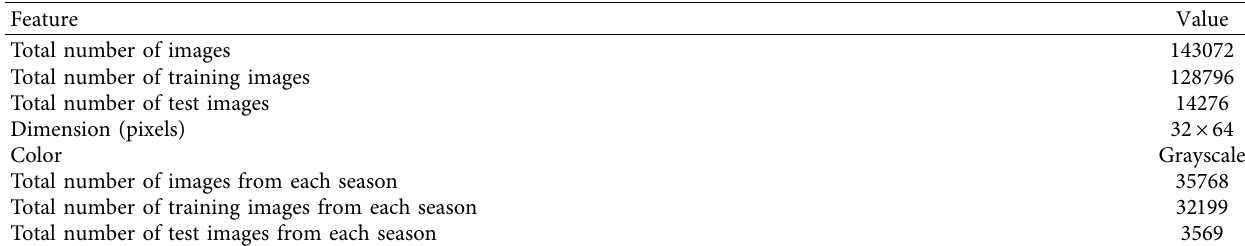
Table 3: Details of the dataset.